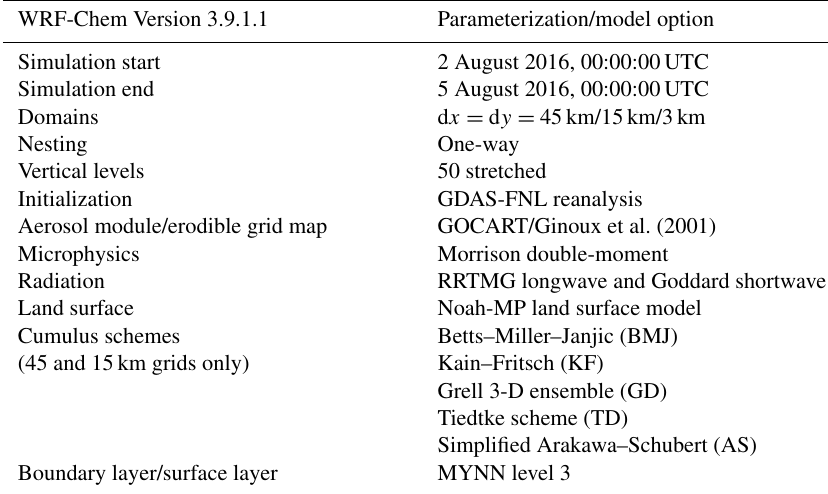
Figure 2. Skew-T diagrams for two radiosonde release sites in Saudi Arabia on 3 August 2016 at 12:00UTC for an inland location (a) and a location nearer to the coast (b) . Table 1. Summary of the WRF-Chem model options utilized and the simulation